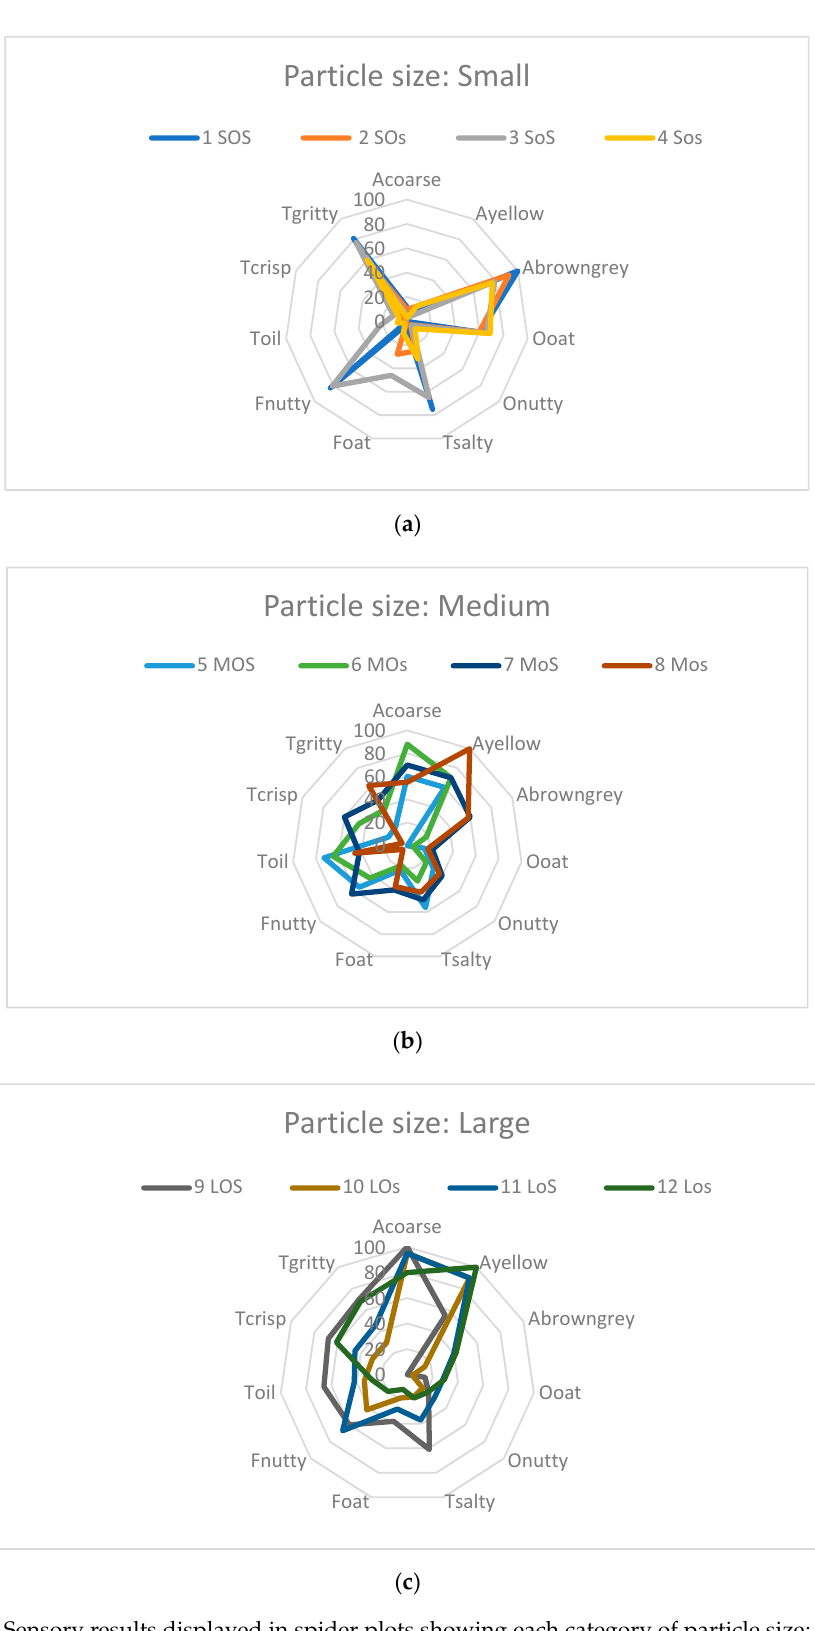
Figure 1. Sensory results displayed in spider plots showing each category of particle size; ( a ) Small particle size, ( b ) Medium particle size, ( c ). Large particle size. Code numbers and identifiers refer to samples in Table 1.